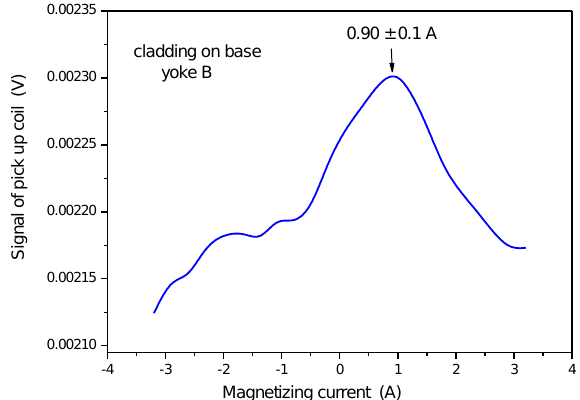
Figure 13. Signal of the pick-up coil as a function of the magnetizing current, measured on the top of